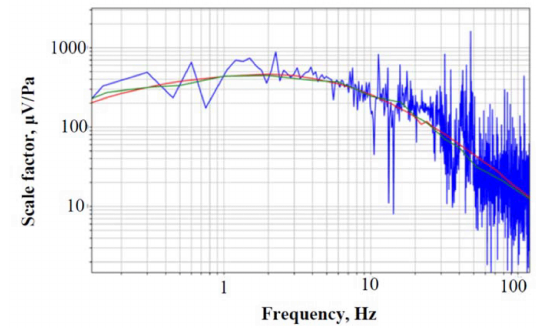
Figure 11. METH self-test calibration (red) with METH calibrating platform calibration (green) and a strong signal calibration curve (blue). Hz on the x axis, µVPa − 1 on the y